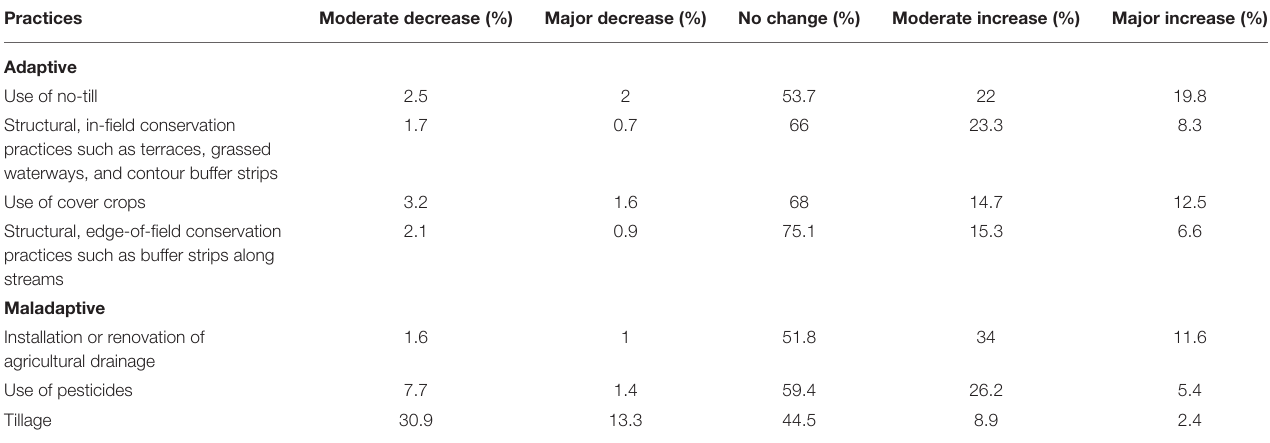
TABLE 2 | Percentage distributions for adaptive and maladaptive actions (dependent variables). Practices